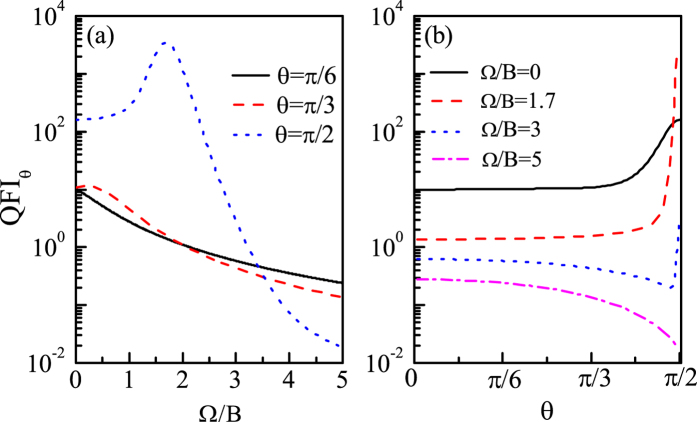
(a) QFIθ as a function of Ω for different directions (b) QFIθ as a function of θ for different Ω. N = 10, B = 1 and Γ0 = 0.03B.